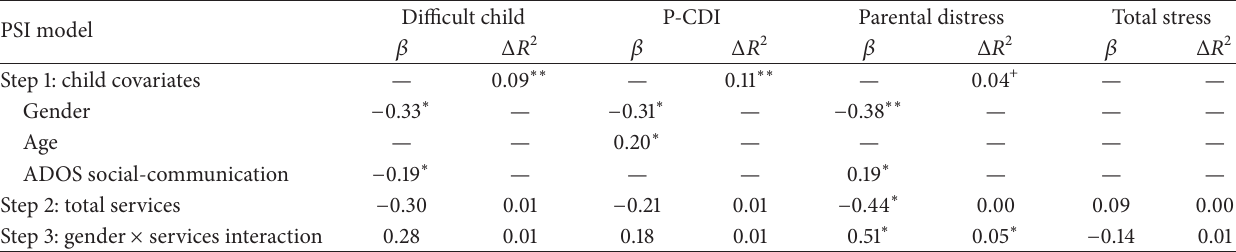
Table 2: Regression analysis predicting parenting stress from total number of services